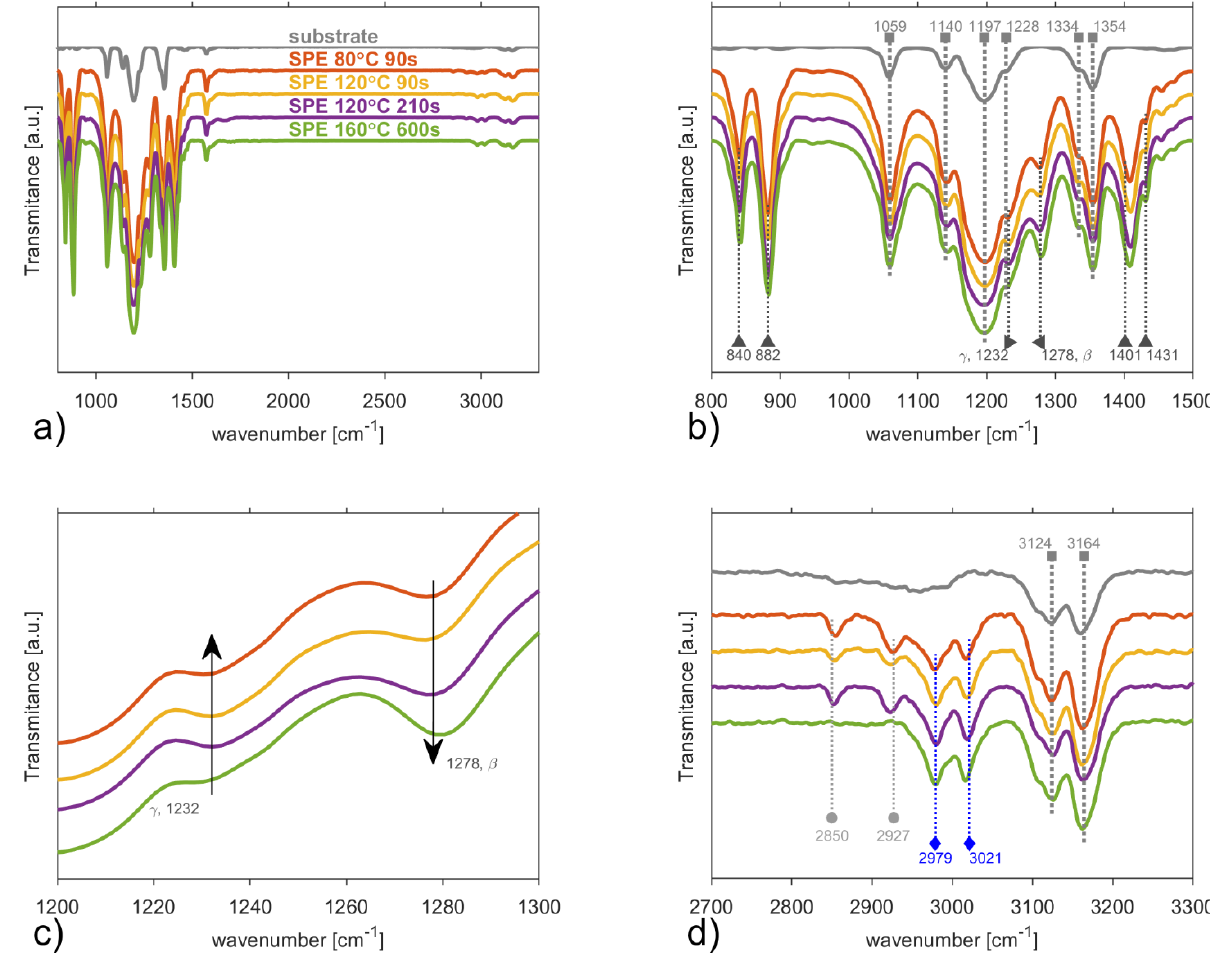
Figure 4. ATR-FTIR spectra of the solid polymer electrolytes after four treatment conditions and substrate in ( a ) the full spectral range 800–1430 cm − 1 , ( b ) the spectral range 800–1500 cm − 1 , ( c ) the spectral range 1200–1300 cm − 1 of exclusive γ -phase and β -phase peaks, and ( d ) the spectral range of C–H stretching region 2700–3300 cm − 1 . Light grey squares represent peaks connected to the substrate. Grey triangles ( ▲◄▼ ) are connected to PVDF peaks. Blue diamonds represent ionic liquid peaks. Grey circles are assumed to be connected to the solvent NMP.